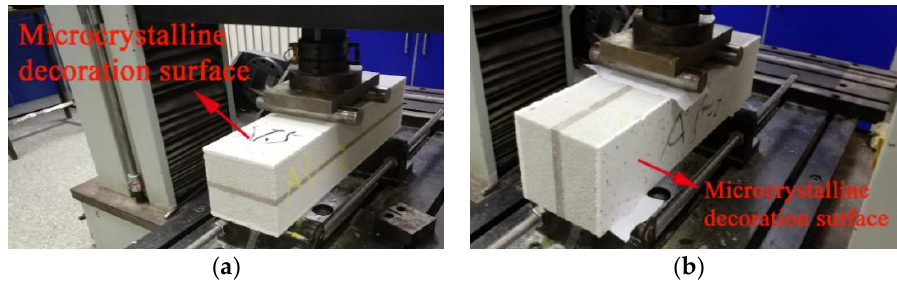
Figure 5. Two ways of placing the group AD specimens. ( a ) Decoration surface on the top (ADt); ( b ) Decoration surface on the side (ADs).